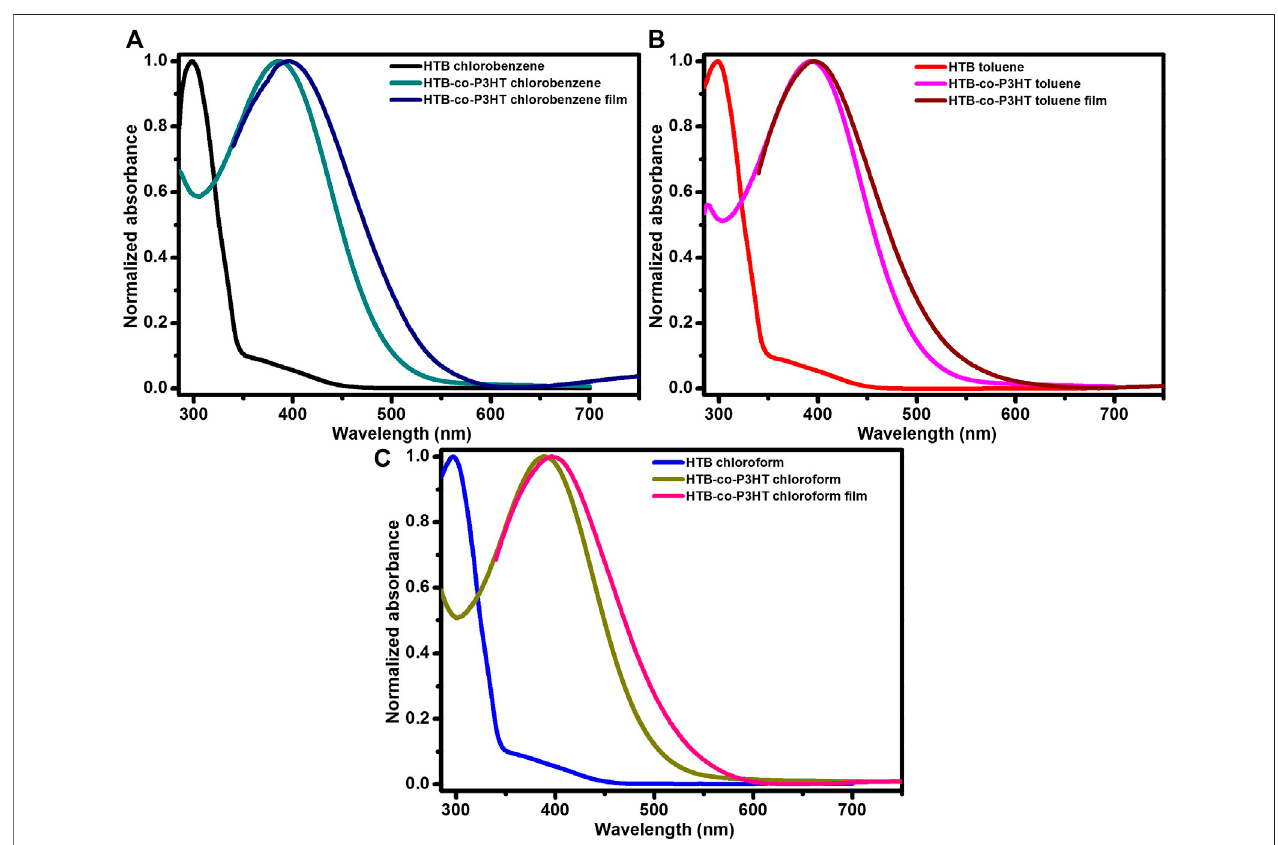
FIGURE 4 | UV-Vis spectra of HTB and HTB-co-P3HT in different solvents. (A) chlorobenzene, (B) toluene and (C) chloroform.